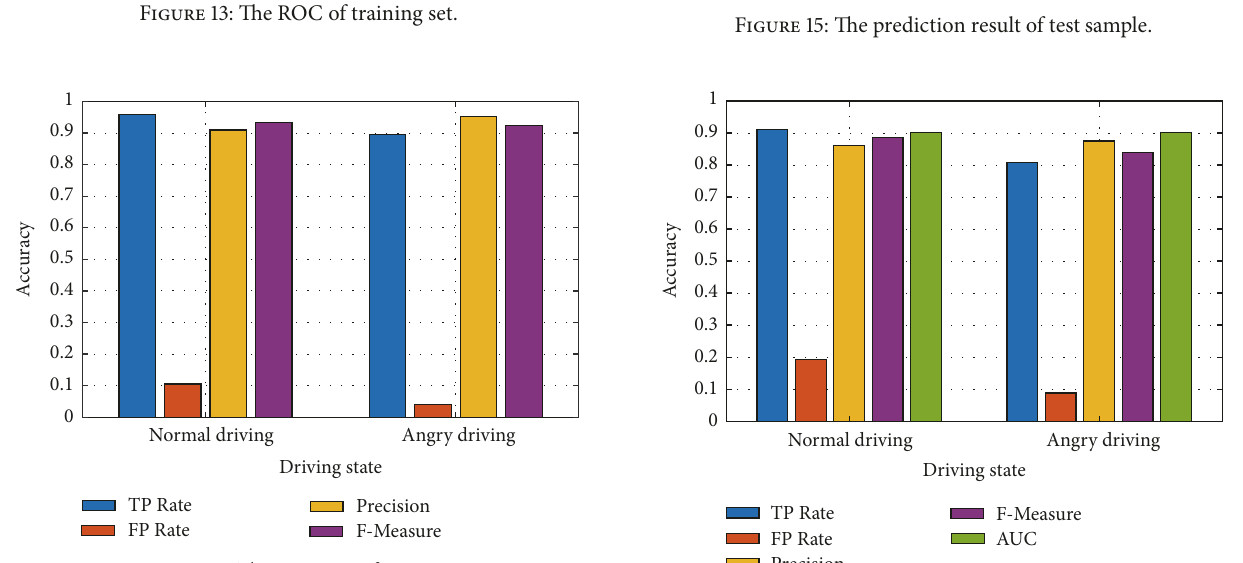
Figure 14: The accuracy of training. the solid bold lines are the ROC curves, and the straight diagonal dashed lines are the reference lines. From Figure 17,